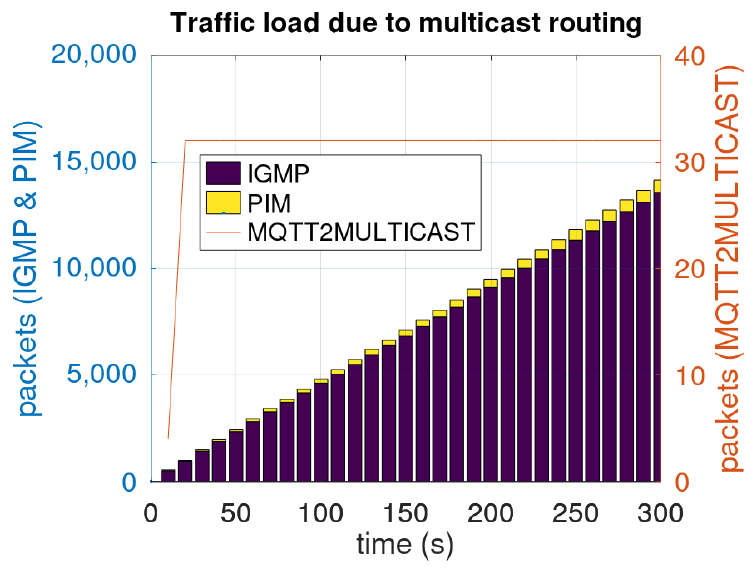
Figure 16. Comparison of traffic due to multicast routing between PIM & IGMP and